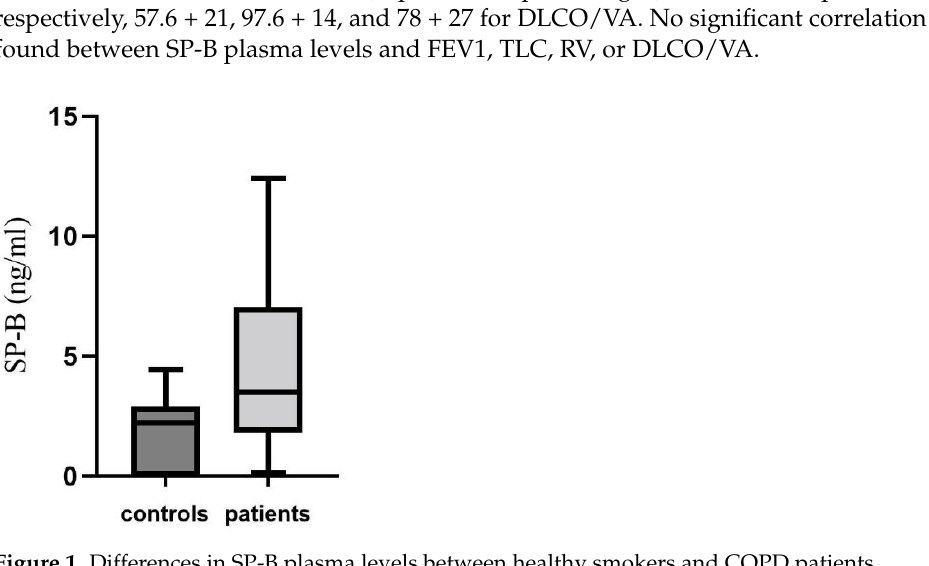
Figure 2. Correlation between delta FEV1 and delta SP-B over the 12- month period (Pearson −0.5; p 0.02). A direct correlation was also found between SP-B plasma levels and BMI (r = 0.3; p < 0.05). On the contrary, no correlation was found between the SP-B plasma levels and clinical findings, especially with the number of exacerbations and symptoms or with the score obtained by completing the CAT and mMRC questionnaires. 4. Discussion